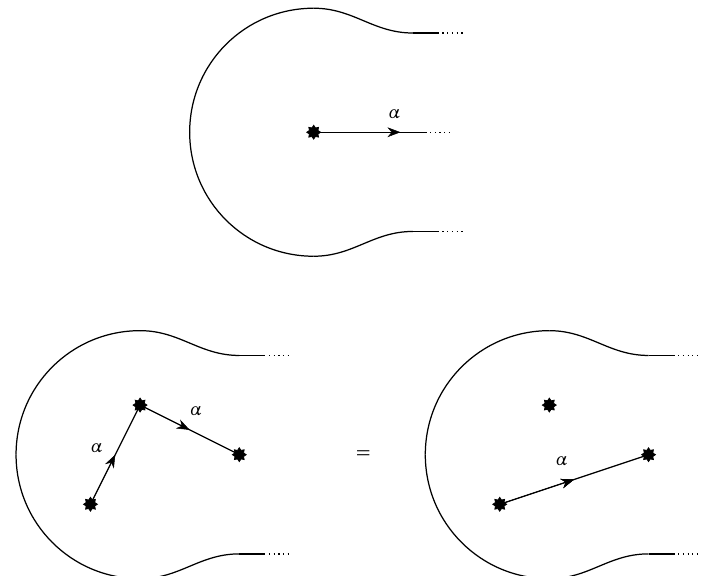
( C , (cid:98) Z , ∗ ) are allowed to end on punctures. α denotes g 1